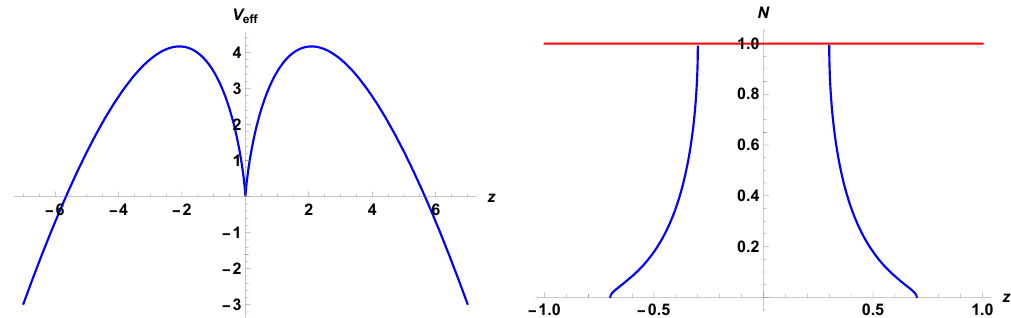
Figure 5 . In the left plot we depict the typical effective potential when R > 2 (unstable regime) and in the right one the typical density of boxes that has a saturation region with two adjacent cuts. This solution exists for relatively small ξ = ξR − R/ 2 , otherwise the well becomes too shallow to eff support a metastable